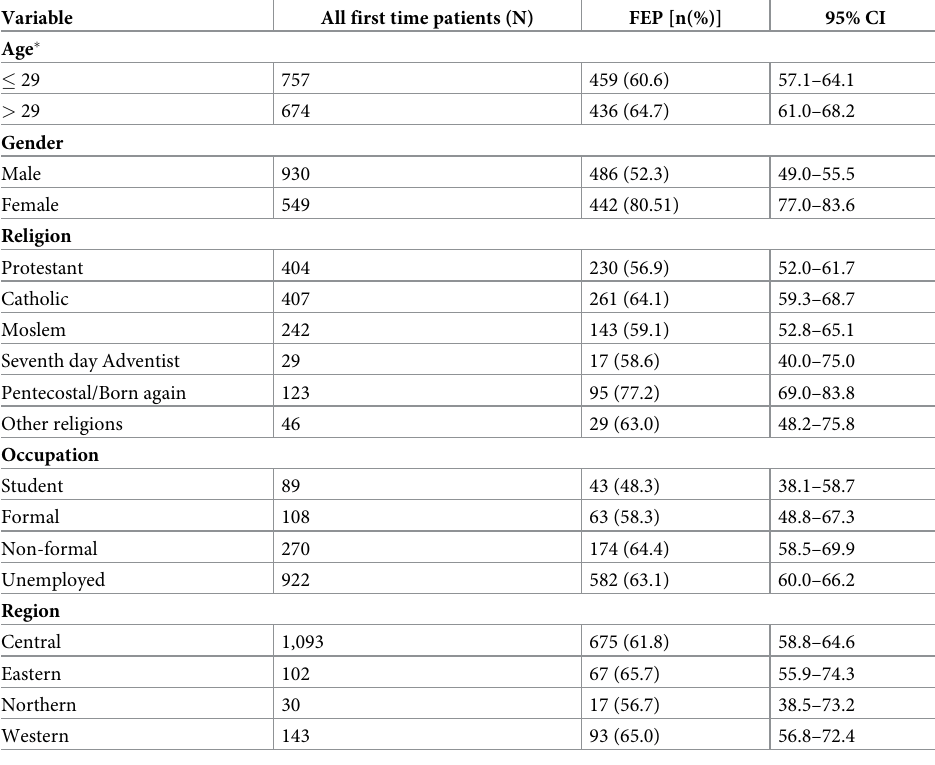
Table 2. Background characteristics of the sample of participants classified as having